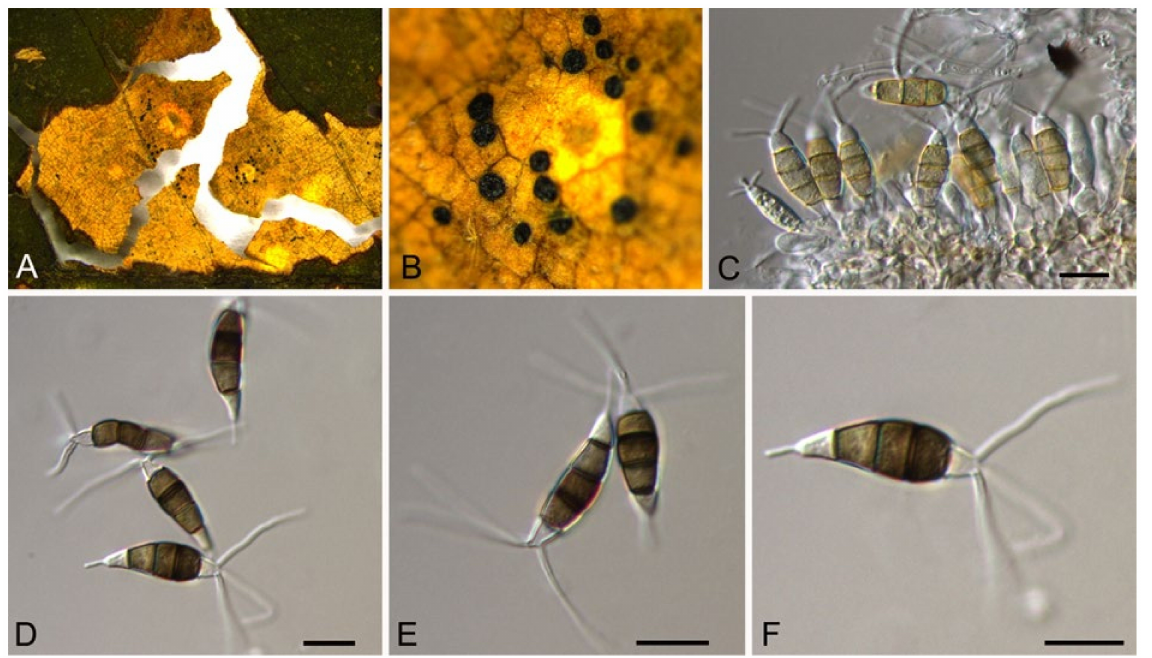
Figure 18. Neopestalotiopsis sp.2 (BJFC-S1790). ( A , B ) Conidiomata on the diseased leaves of Castanea mollissima ; ( C ) Conidio- genous cells giving rise to conidia; ( D – F ) Conidia. Scale bars: ( C – F ) = 10 µ